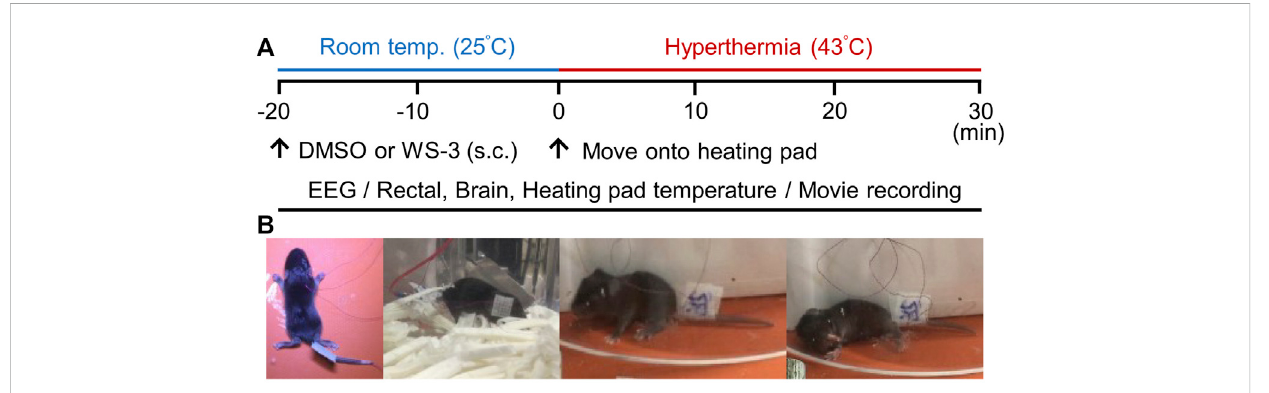
FIGURE 1 Experimental protocol for inducing febrile seizures (FSs) via hyperthermia. (A) Protocols for recording electroencephalography data and movies, measuring rectal, brain and heating pad temperatures, and analyzing the effects of transient receptor potential melastatin 8 agonist treatment. (B) Postoperative images of postnatal day 7 mice and a typical FS involving loss of the righting re fl ex caused by